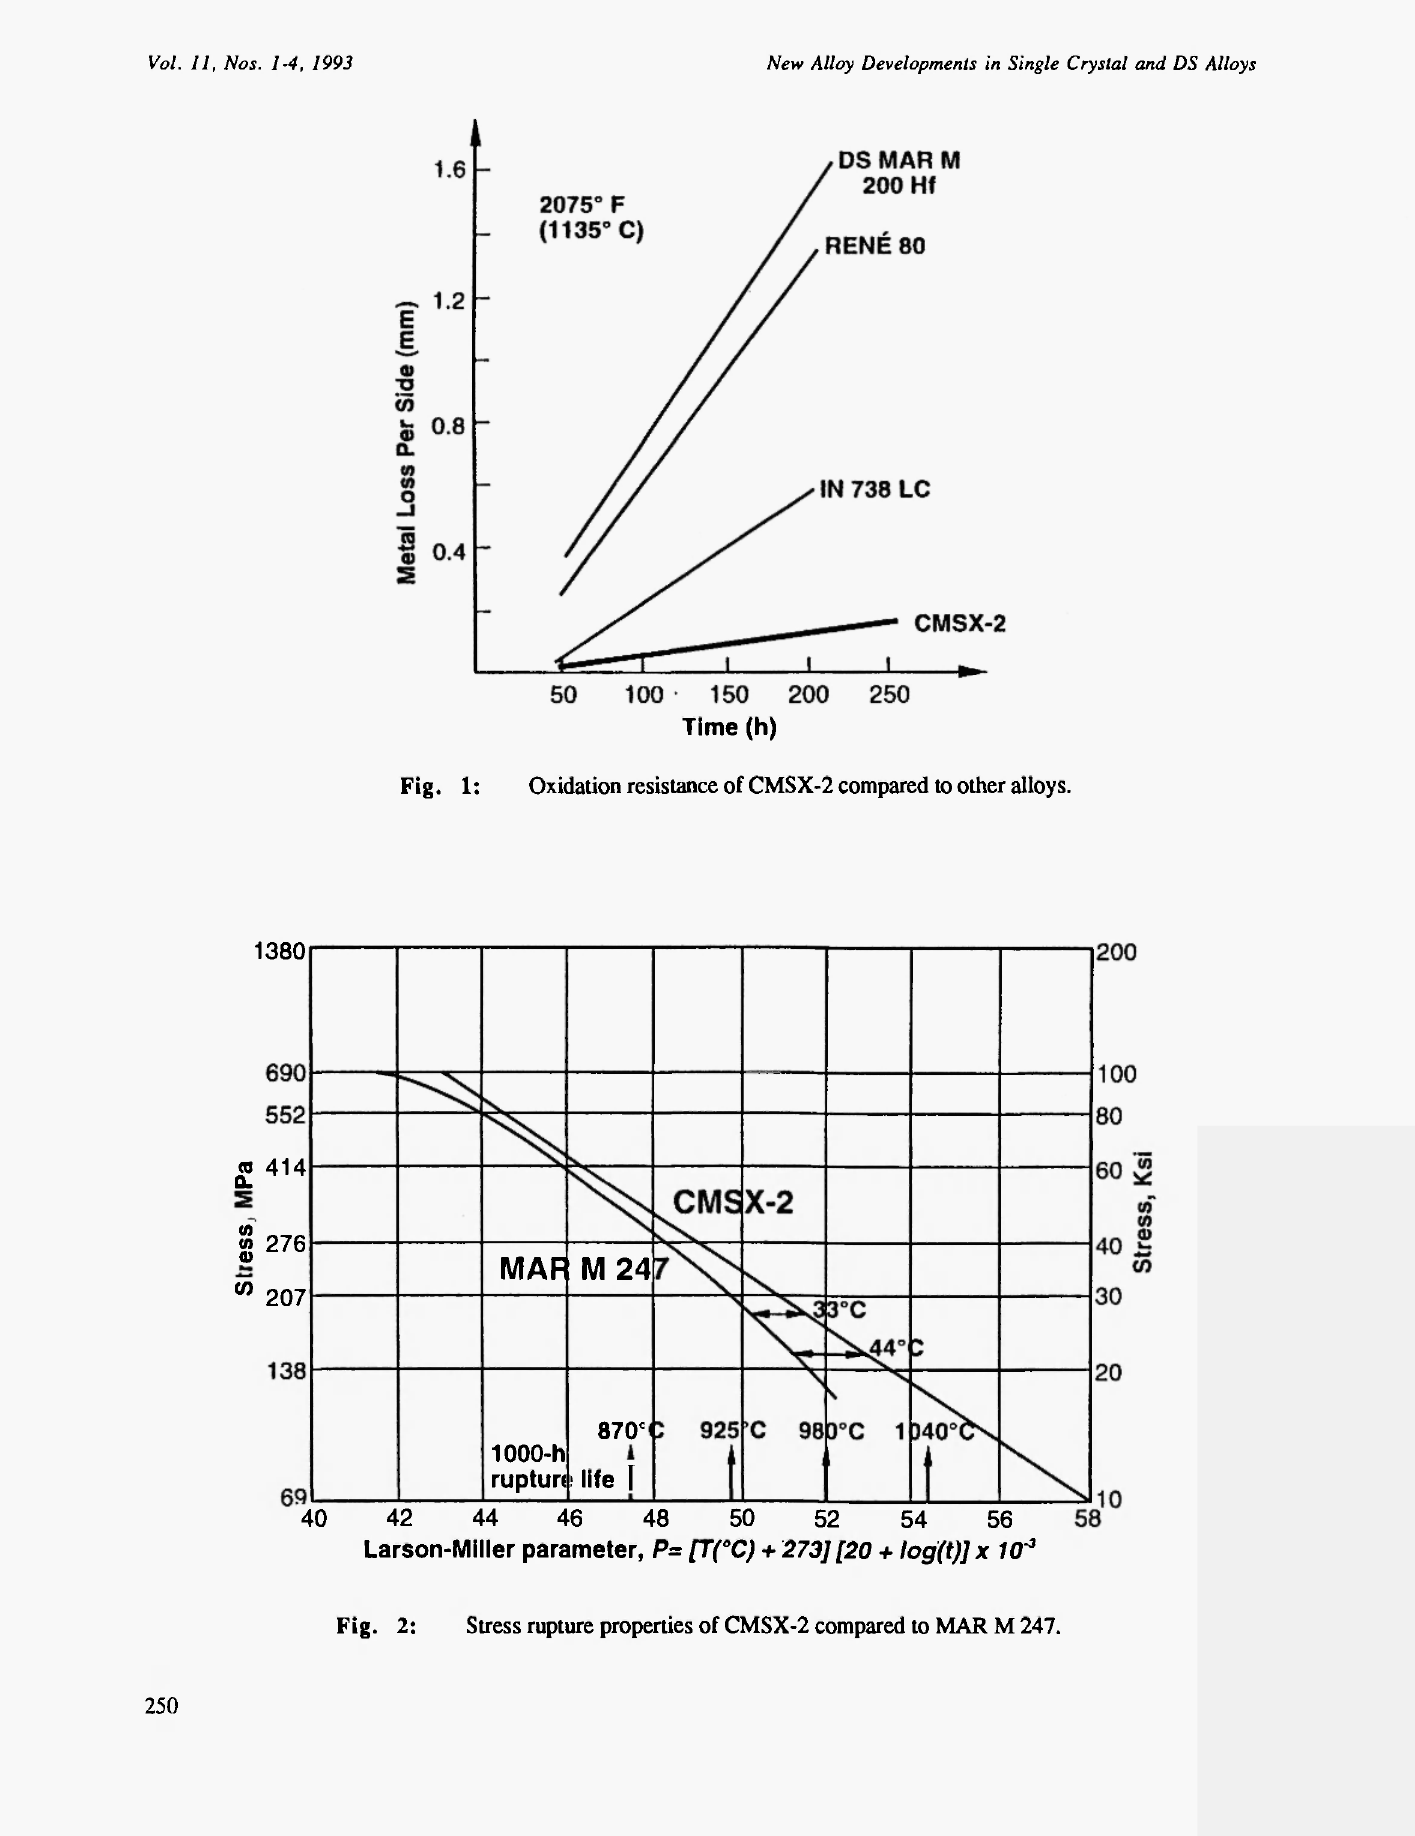
Fig. 2: Stress rupture properties of CMSX-2 compared to MAR Μ